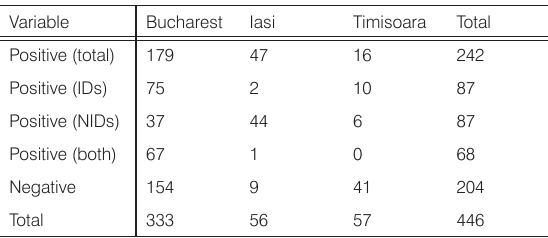
Table 1. Distribution of positive and negative cases on centers. IDs =illegal substances, NIDs = non-illegal substances Variable